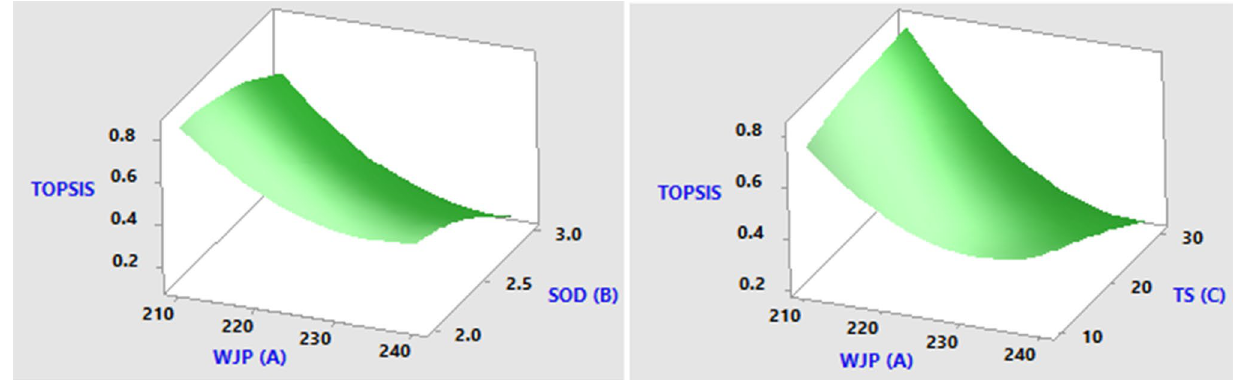
Table 12 ANOVA for TOPSIS model of Al/B material